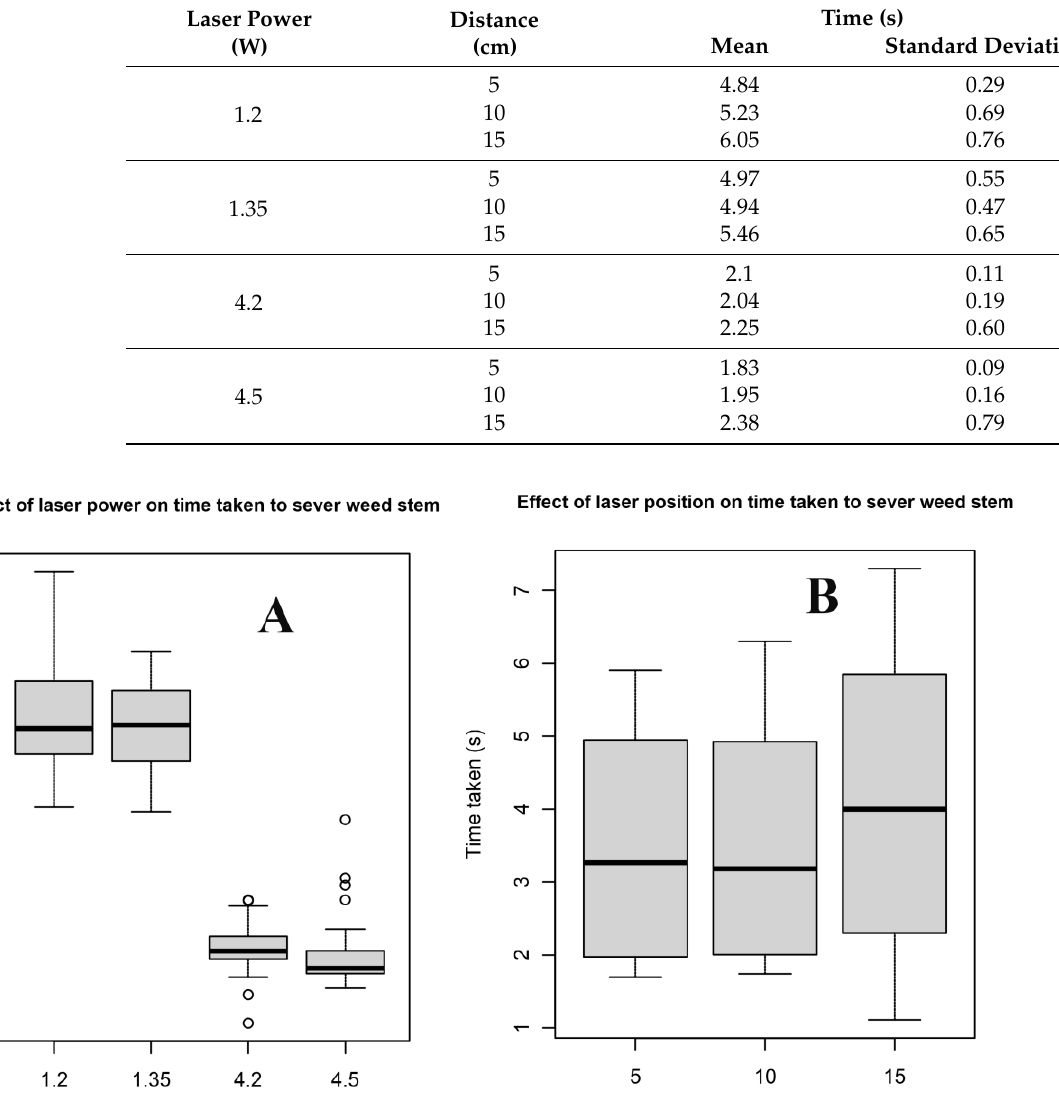
Table 1. Mean time taken by each diode laser to sever weed stems at 5, 10, and 15 cm.